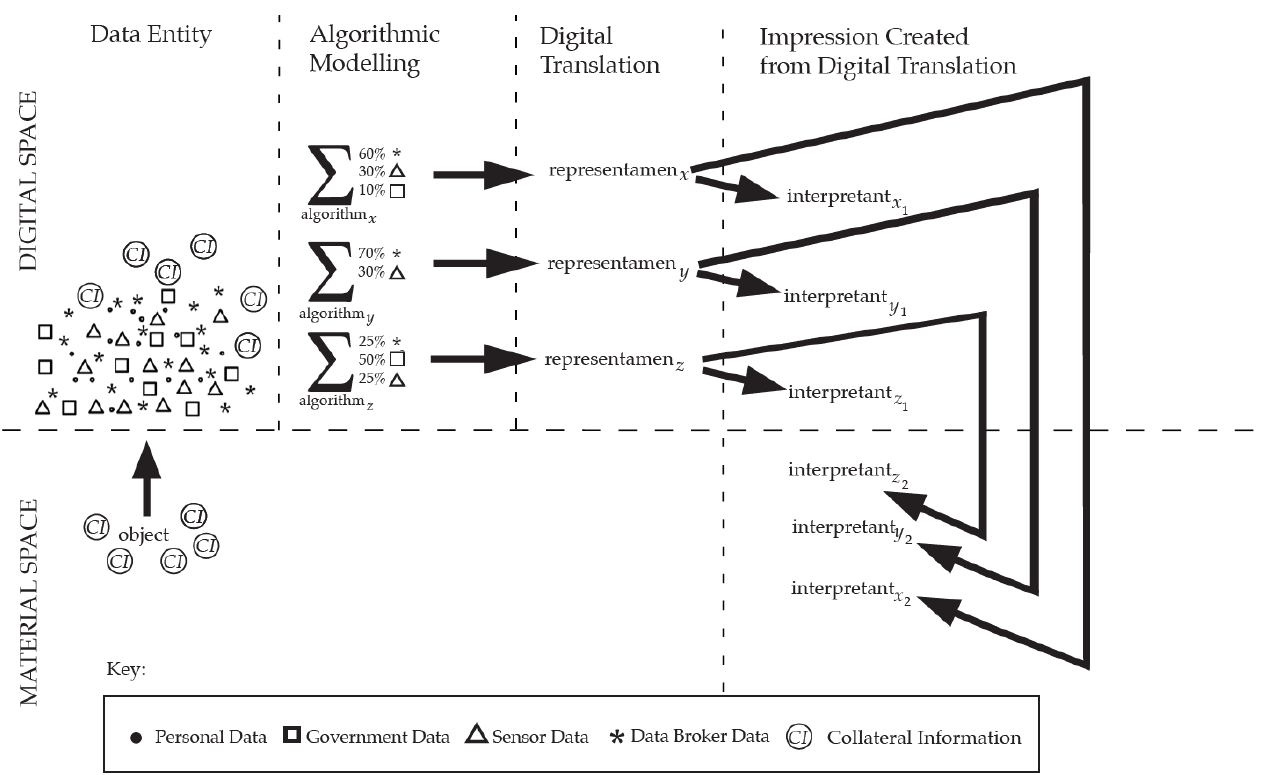
Figure 3. The role of algorithms in digital